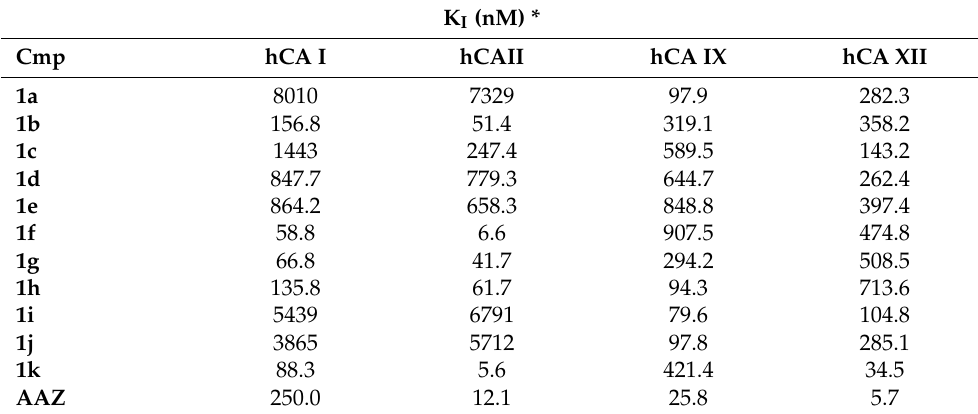
Table 2. Inhibition data of human CA isoforms I, II, IX, and XII with labeled compounds and AAZ by a stopped-flow CO 2 hydrase